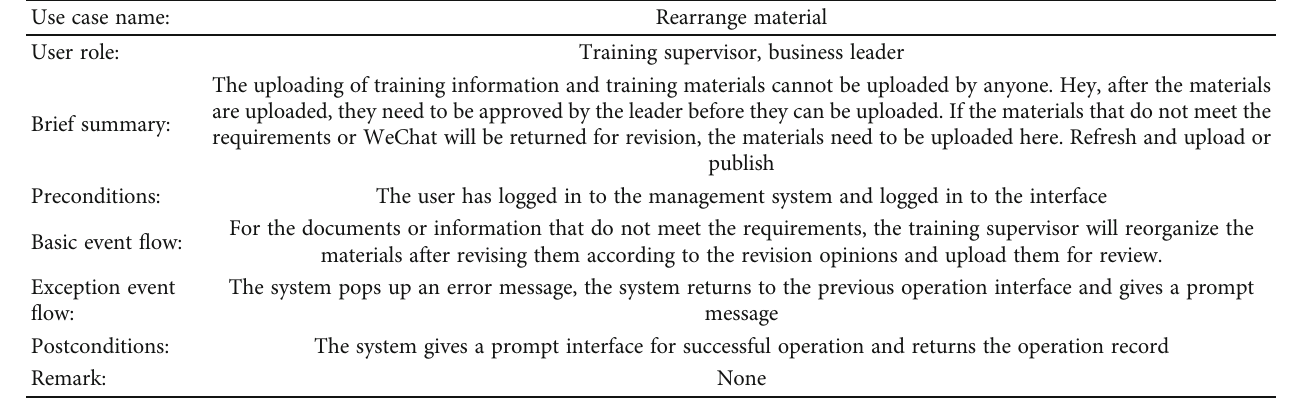
Table 3: Rearranged material use case speci fi cation